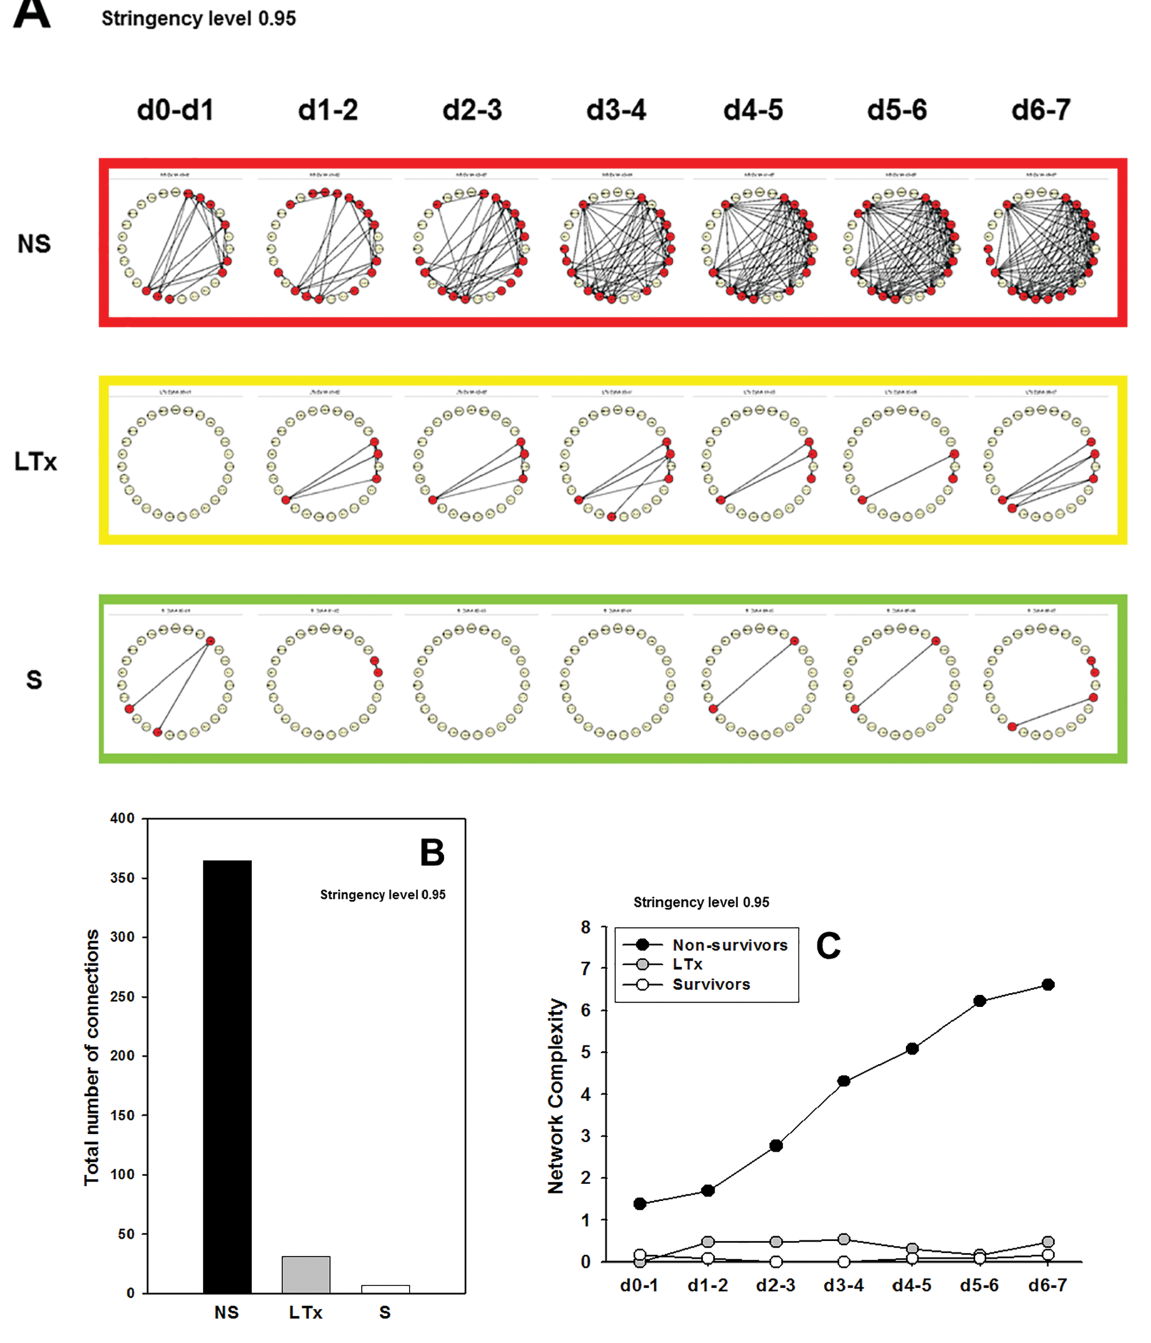
Figure 2. Dynamic network analysis (DyNA) of circulating inflammatory mediators in PALF patients. Circulating inflammatory mediators in serum samples from PALF spontaneous survivors (S, n = 61 patients), nonsurvivors (NS, n = 12 patients) and liver transplant recipients (LTx, n = 28 patients) were measured and DyNA (stringency level = 0.95) was performed during seven time frames, d 0–1, d 1–2, d 2–3, d 3–4, d 4–5, d 5–6, d 6–7, as described in Materials and Methods. Panel A shows an overview of all the networks and mediator connections (closed circles represent mediators with at least one connection to another mediator; open circles represent mediators that had no connections to other mediators as determined by DyNA). Panel B represents the total number of connections for each group of patients over all time intervals. Panel C shows the network complexity for each group of patients during each of the seven time frames calcu- lated, as described in Materials and